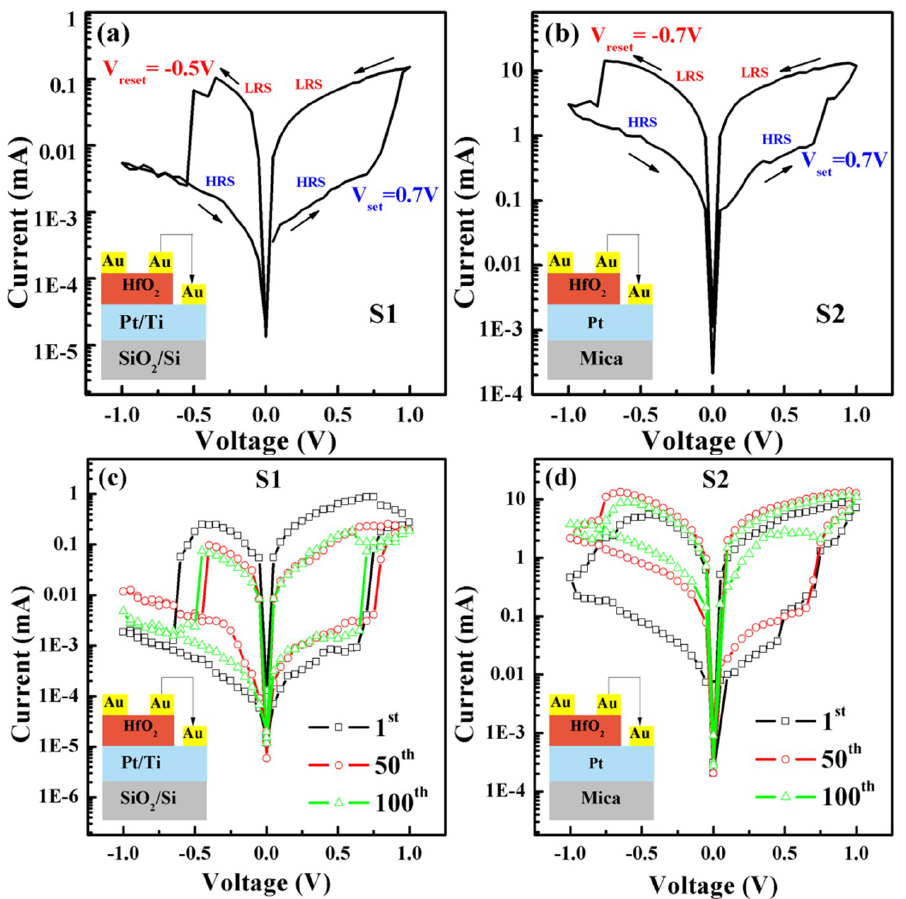
Figure 5. Resistive switching characteristics of ( a ) Au/HfO 2 /Pt/Ti/SiO 2 /Si, ( b ) Au/HfO 2 /Pt/mica, ( c ) Au/HfO 2 /Pt/Ti/SiO 2 /Si with 100 sweep cycles, and ( d ) Au/HfO 2 /Pt/mica with 100 sweep cycles.